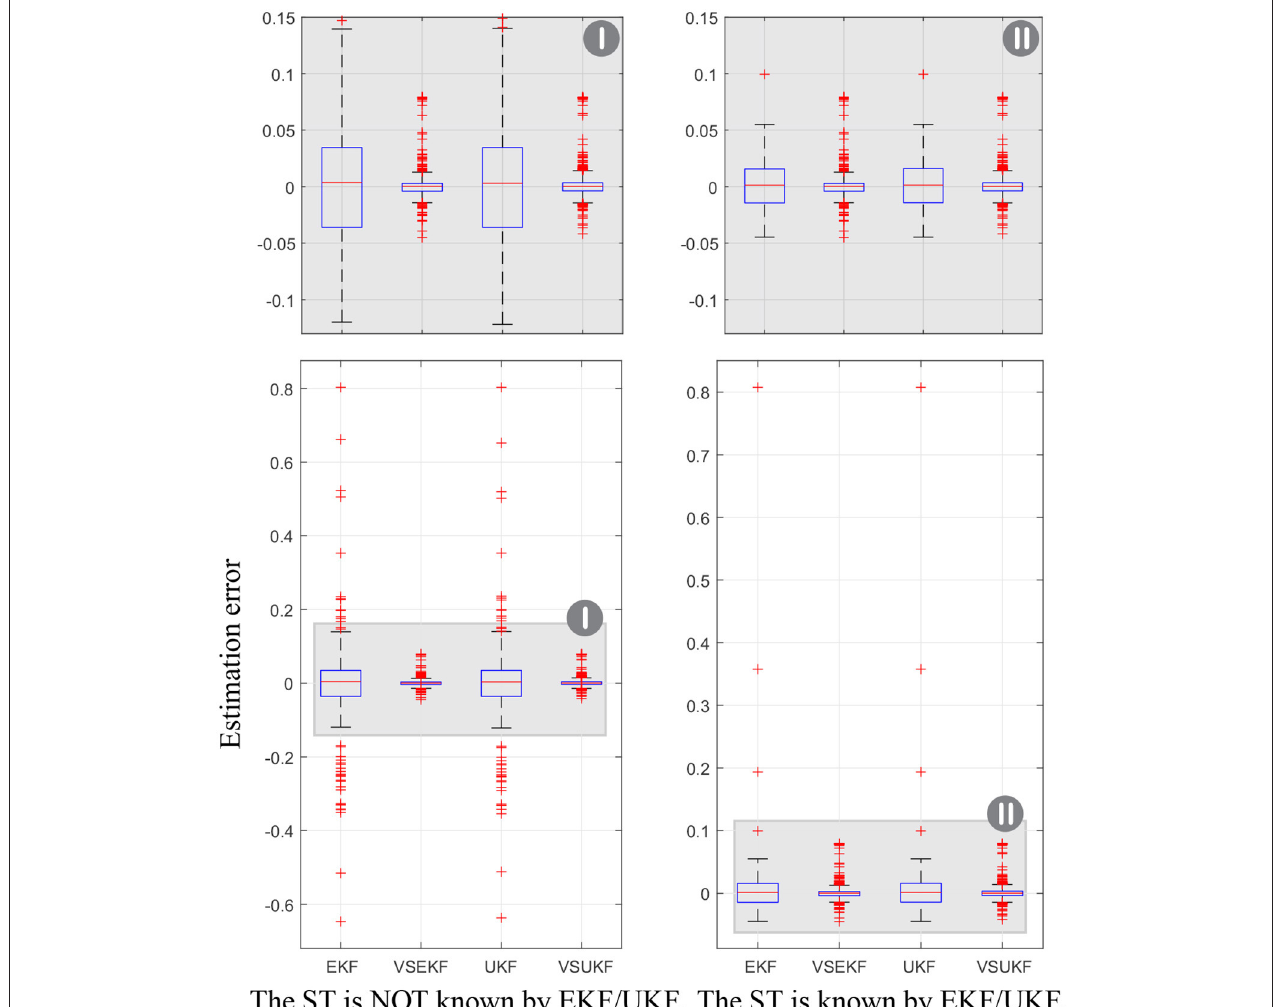
FIGURE 5 | Estimation error of Van der Pol oscillator state x 1 using fixed and variable step size Extended/Unscented Kalman Filter.